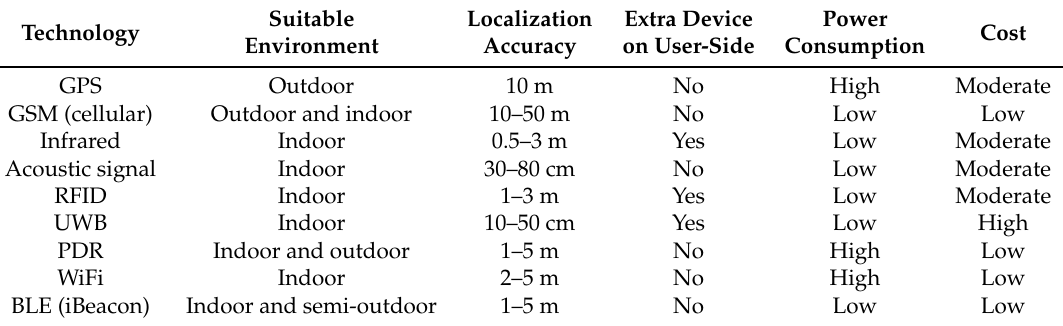
Table 1. Overview of technologies for location-based services